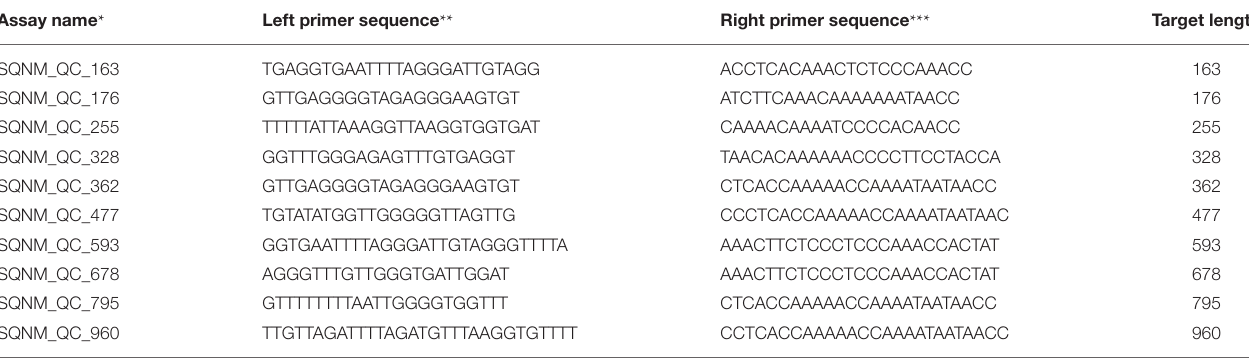
TABLE 2 | The primers used for assessing the degradation of your bisulfite treated DNA. Assay name * Left primer sequence ** Right primer sequence *** Target